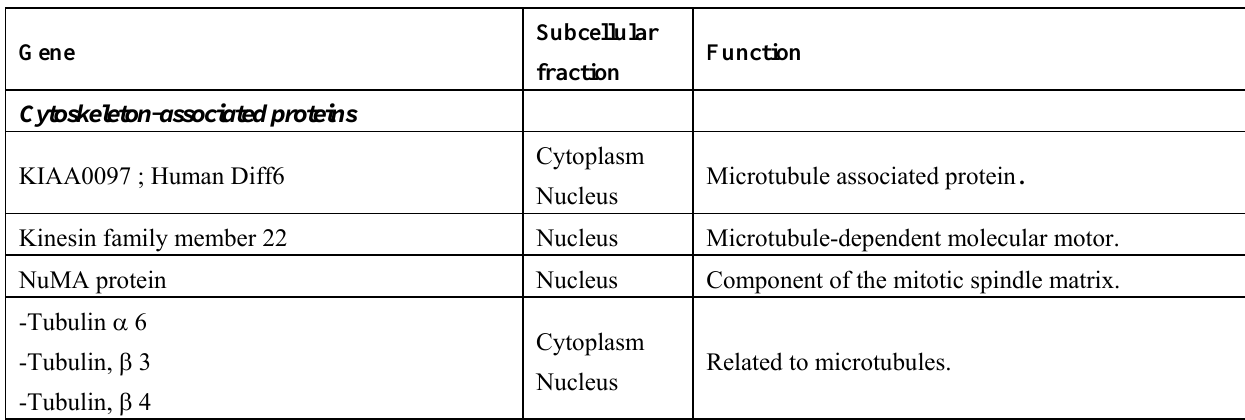
Table 2. Summary of functional categories of IGF-IR promoter-bound proteins identified by MS.